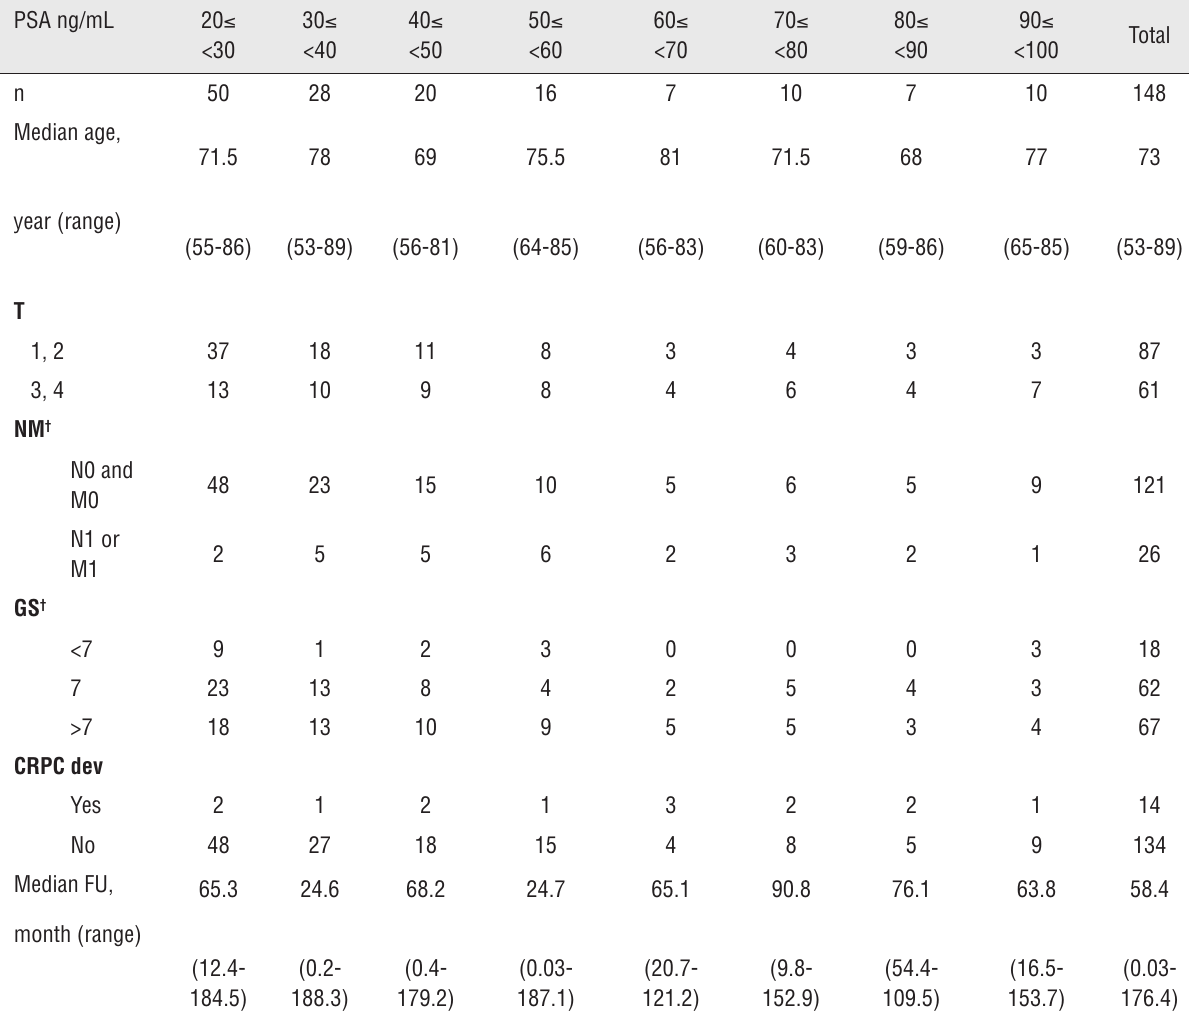
Table 1 - Patient